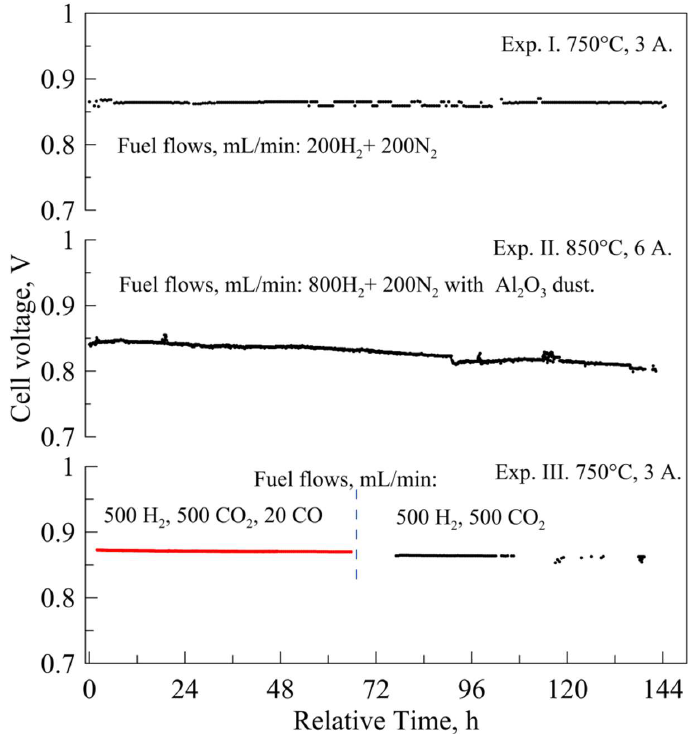
Figure 7. Evolution of voltage during intermediate-term experiments for various test conditions and inert powder aerosol contamination.